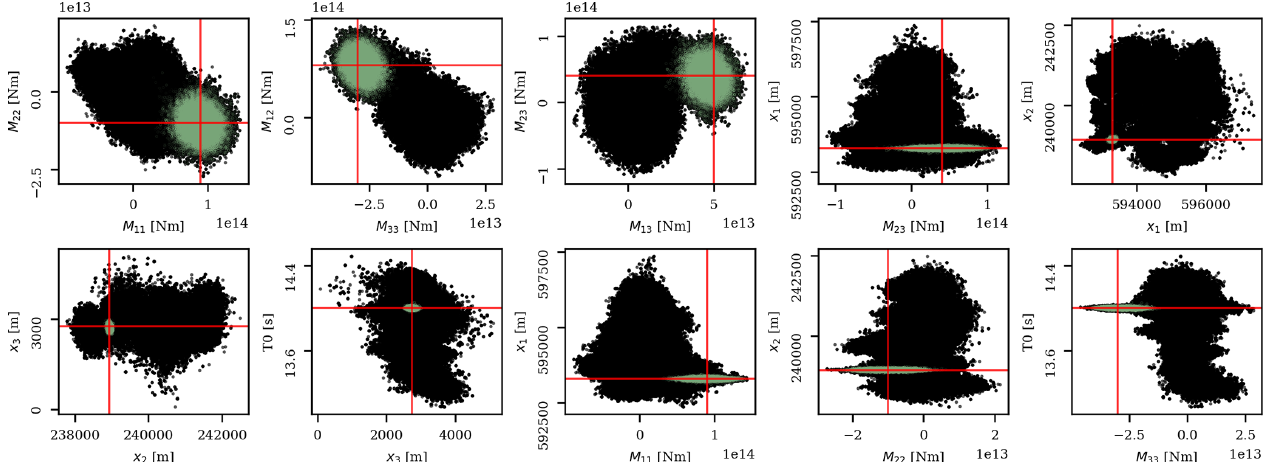
Figure 11. The same 10 two-dimensional marginal probability densities as in Fig. 7. Note that scales on horizonal and vertical axes differ. Black dots are the samples from all chains, whereas the green dots represent the samples from chains with a posterior mean that yields a VR higher than 85% of the maximum VR. The red lines represent the true